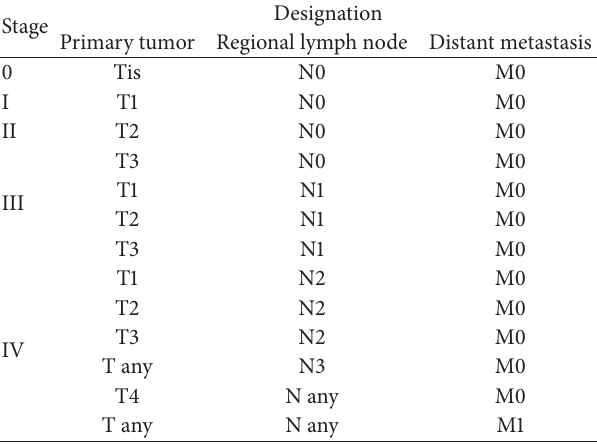
Table 3: AJCC tumor, node, metastasis (TNM) 2010 cSCC